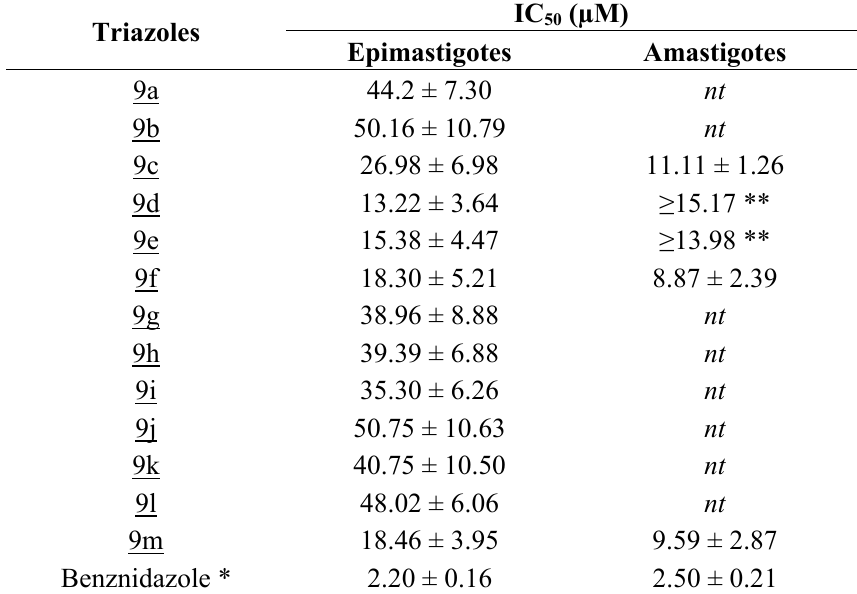
Table 1. Toxic effects of new triazoles ( 9a – 9m ) on proliferative forms of T. cruzi